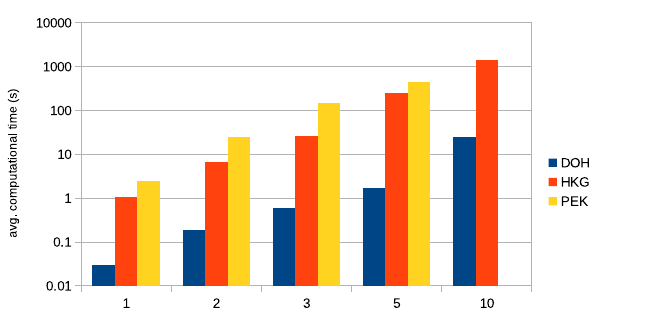
Figure 3. Computational times for a single aircraft in seconds for varying u . Note, that for PEK and u = 10 the experiments could not be completed within 10 days limit.